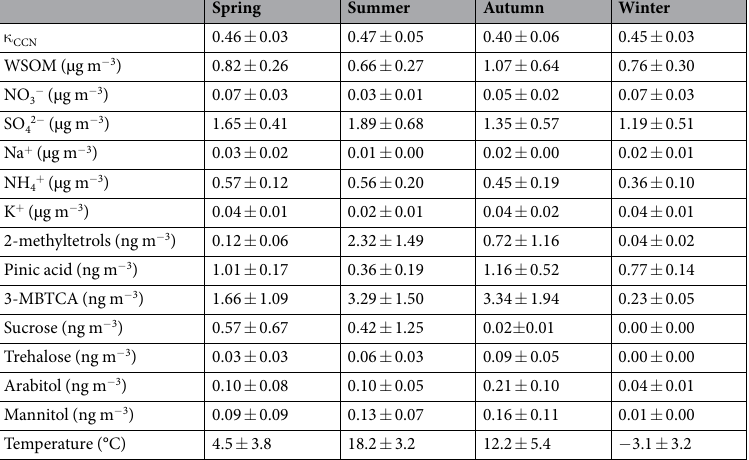
Table 1. Average κ CCN and mass concentrations of WSOM, inorganic species, and biogenic molecular tracers, together with the ambient temperature in each season for the year 2013. Individual seasonal category is